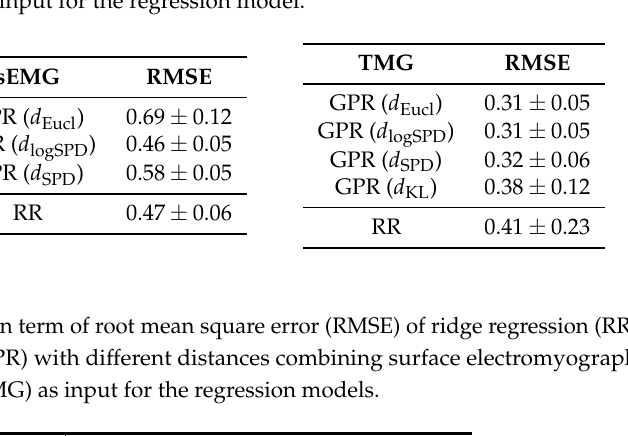
Table 2. Performance in term of root mean square error (RMSE) of ridge regression (RR) and Gaussian process regression (GPR) with different distances using surface electromyography (sEMG) or tactile myography (TMG) as input for the regression model.